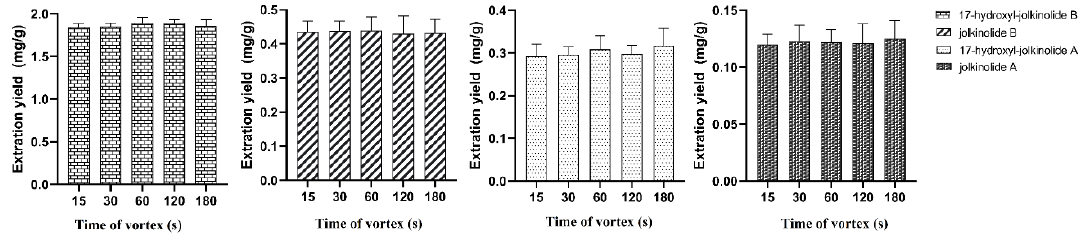
Figure 6. Time of vortex.